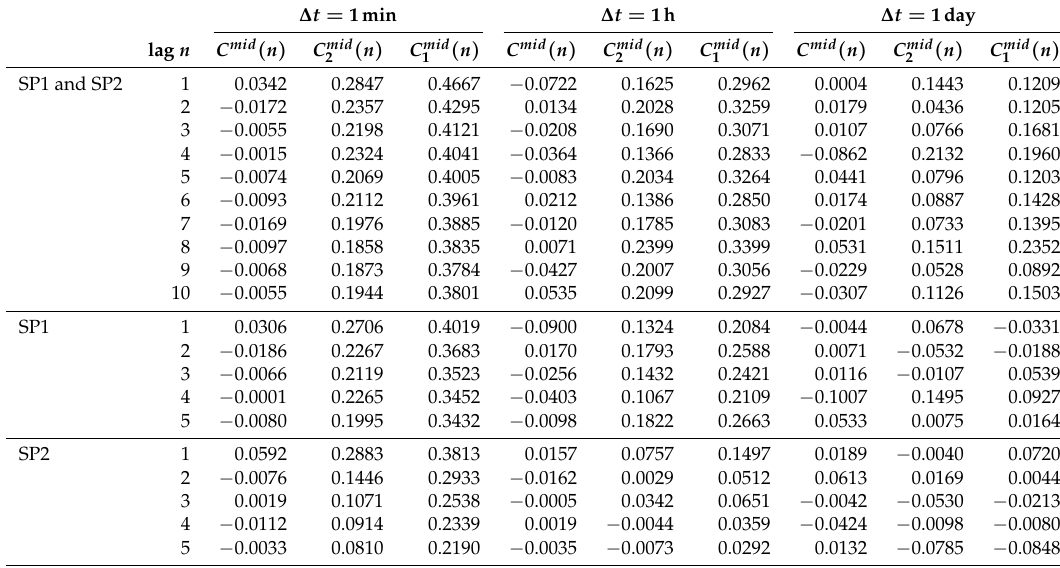
Table 8. Autocorrelation of logarithmic, absolute and squared returns. We compute the autocorrelation ( n ) and C mid ( n ) for different lags n , different time scales ∆ t and different functions C mid ( n ) , C mid 2 1 subperiods. ∆ t =